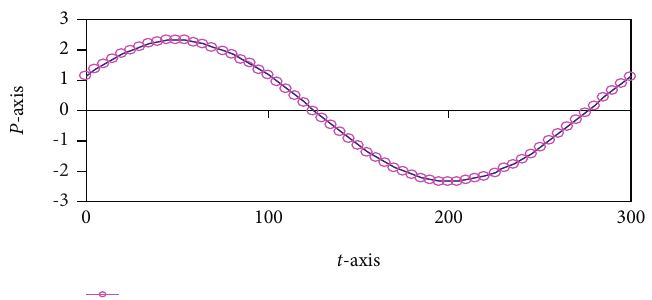
Figure 5: The analytical and numerical solutions P against the time t q(cid:5) (cid:6)(cid:14)